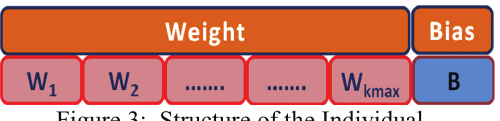
Figure 3: Structure of the Individual